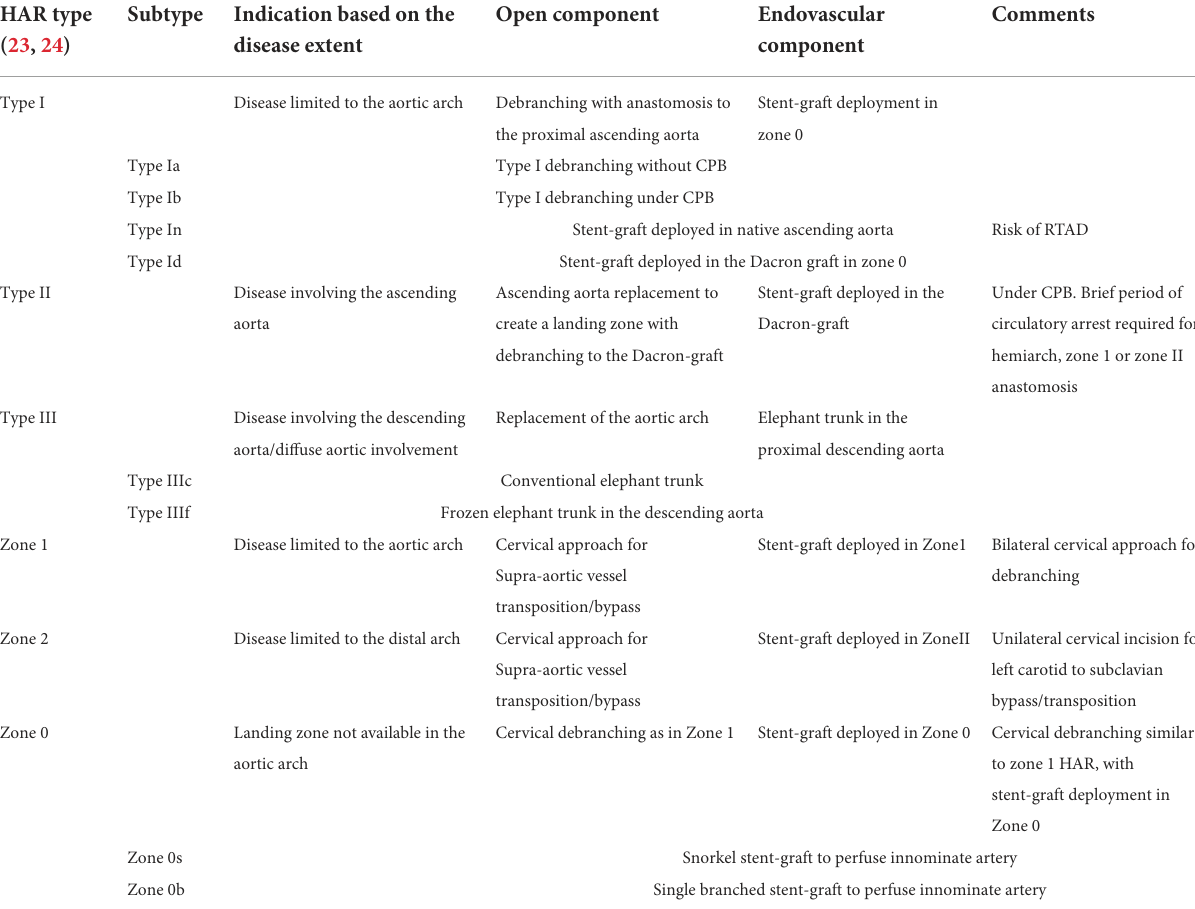
TABLE 1 Different types and subtypes of Hybrid aortic arch repair based on the extent of endovascular coverage and open component.